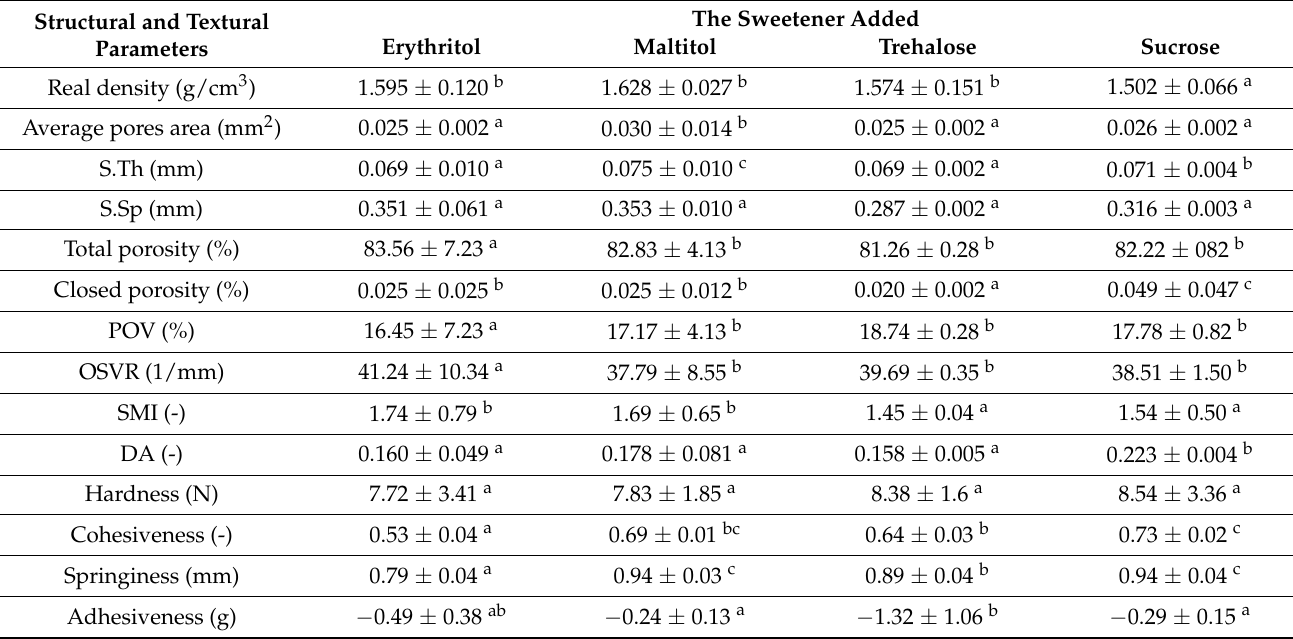
Table 3. The 2D and 3D structural and textural parameters of sponge cakes with sweetener (each value is presented as mean ± SD; values with the same letter in a line are not significantly different at a p <